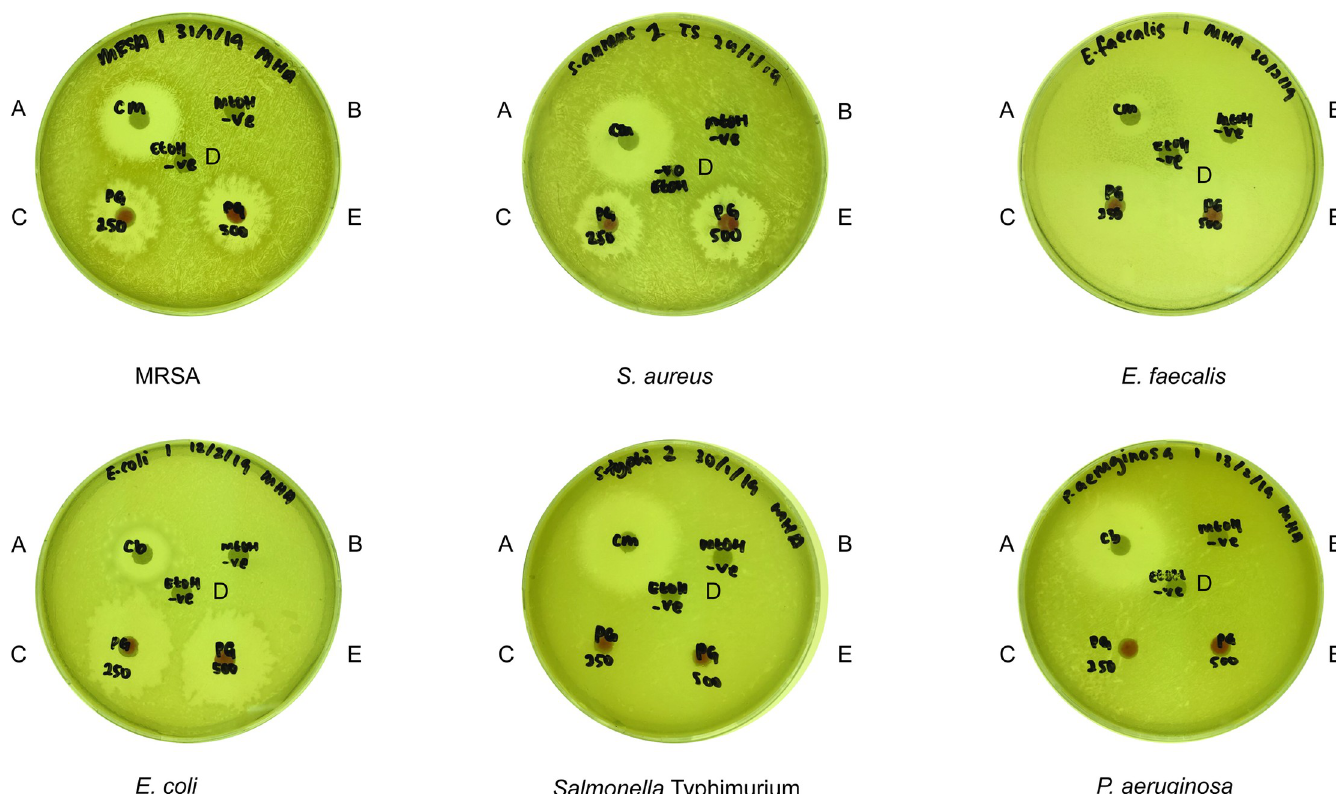
Fig 4. Disc-diffusion assay of selected pathogenic bacteria after 24 hours exposure to prodigiosin. The antimicrobial property of prodigiosin was evaluated using the Kirby-Bauer standardised disc-diffusion assay. Filter paper discs were impregnated with (A) 35 μ g/ μ L chloramphenicol (positive control), (B) 95% methanol (negative control, used as solvent for solubilising prodigiosin extract), (C) 250 μ g/ μ L crude prodigiosin (D) 500 μ g/ μ L crude prodigiosin and (E) 99% ethanol (negative control; used as solvent for chloramphenicol).